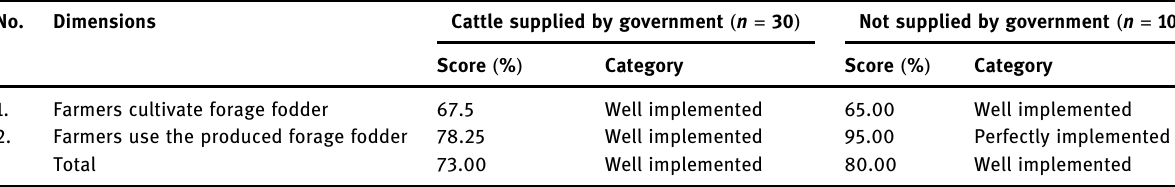
Table 3: Breeders ’ behavior in cultivating forage fodder No.